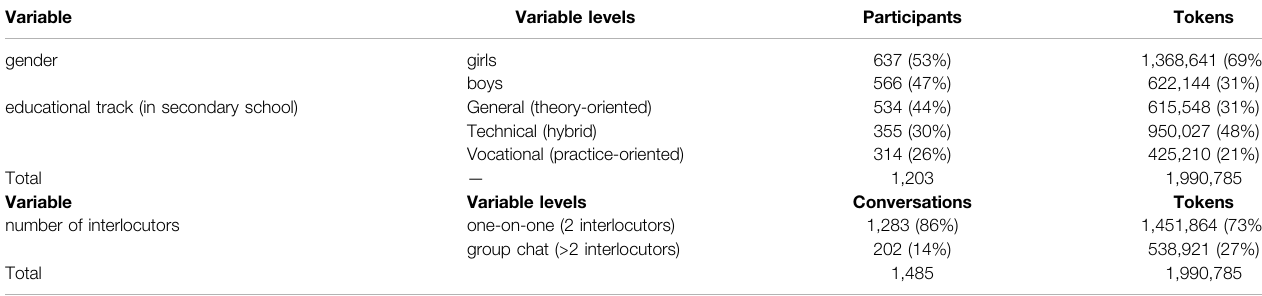
TABLE 2 | Distributions in the dataset with respect to confounding factors.